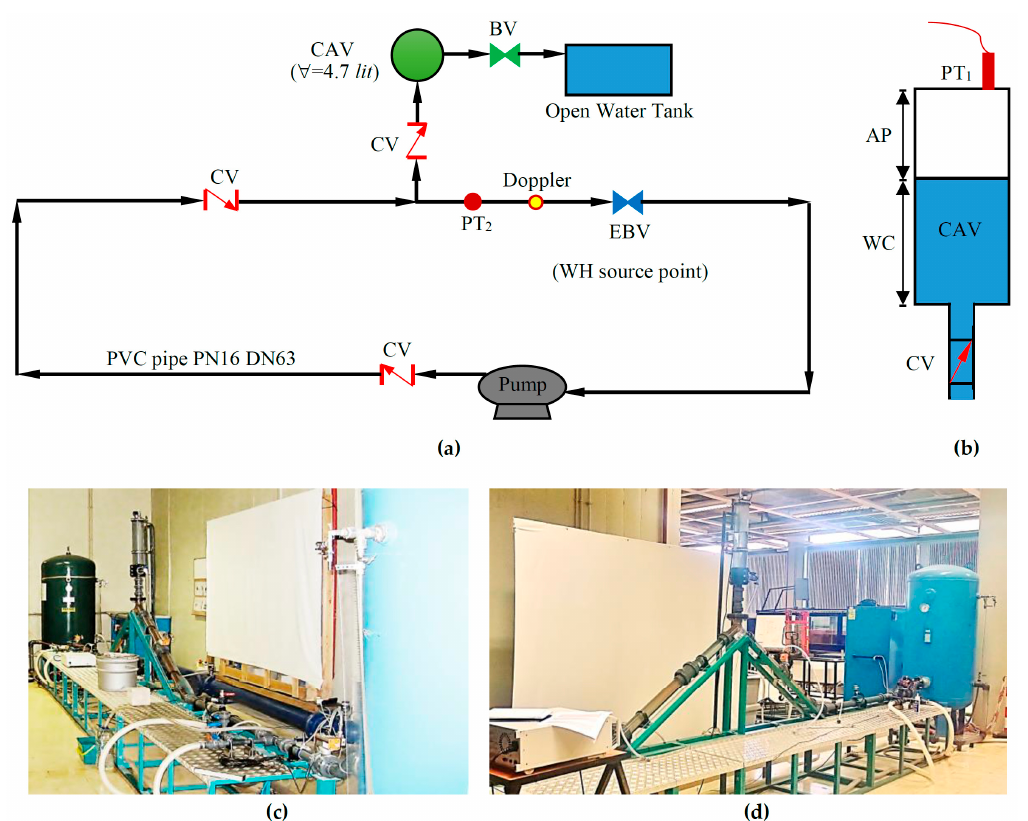
Figure 1. Scheme of experimental apparatus and components; ( a ) system; ( b ) compressed air vessel (CAV); ( c ) upstream side of the apparatus; ( d ) downstream side of the